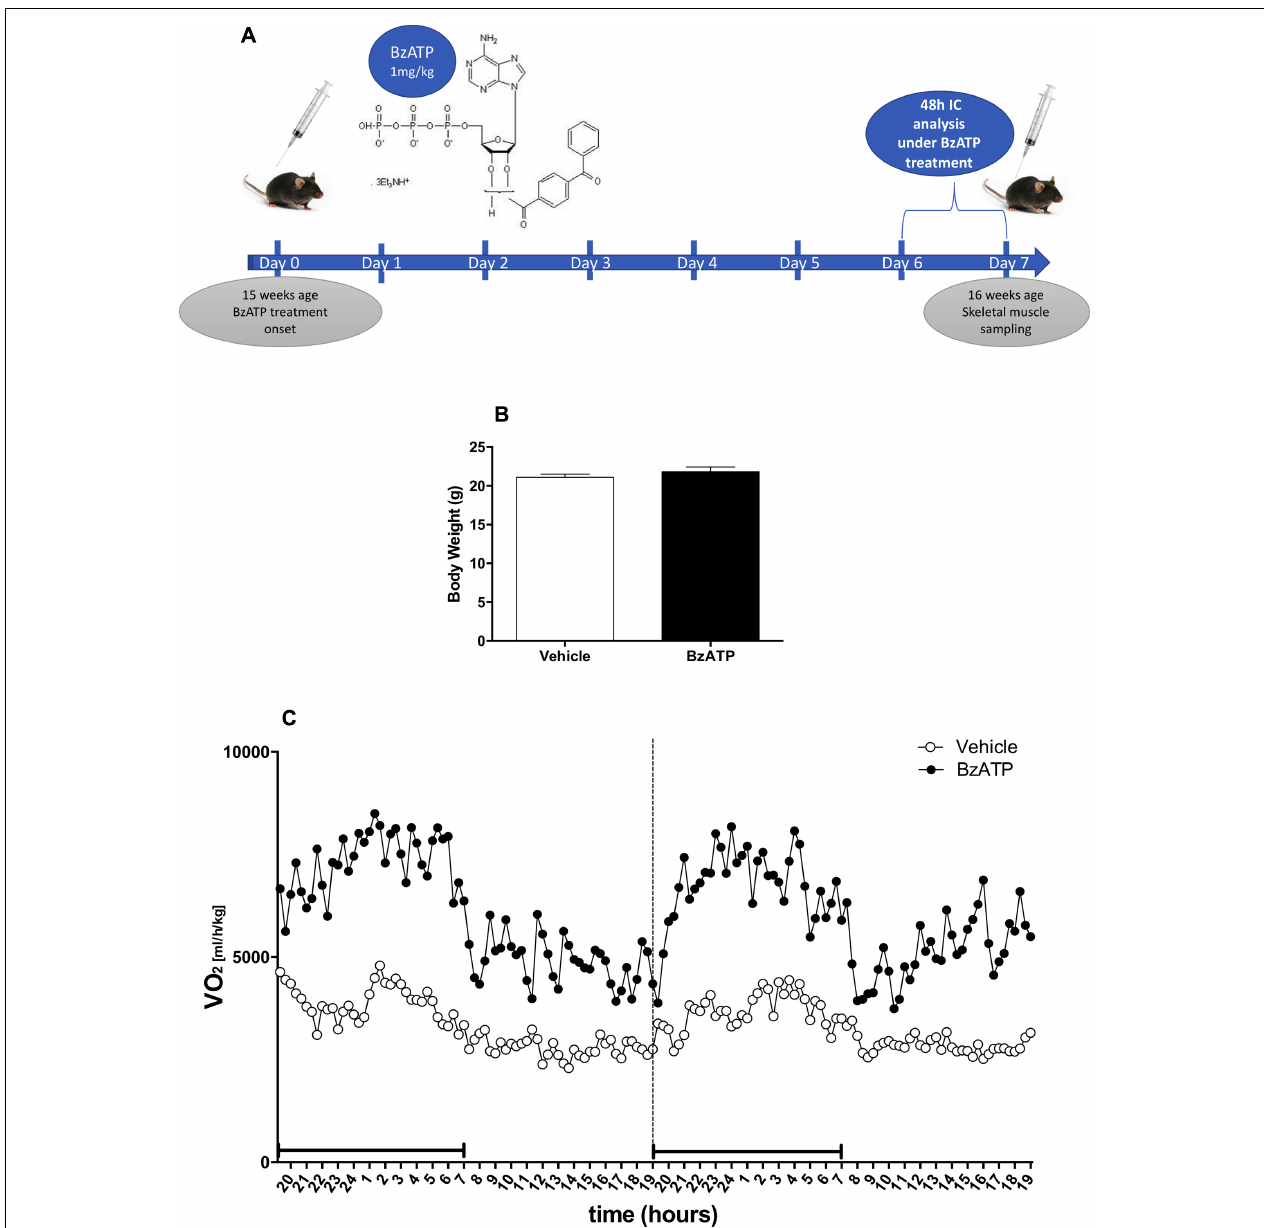
FIGURE 1 | Experimental plan and effects of 7-days BzATP administration on whole oxygen consumption. Adult (15 weeks-old) female C57BL/6J mice were daily i.p., administered with PBS or 1 mg/Kg BzATP for 7 days. At day 5, vehicle ( n = 5) and BzATP-treated mice ( n = 5), were introduced in the metabolic chambers to adapt for 24 h, and then subjected to IC recording for 48 h (days 6 and 7). (A) Schematic representation of experimental plan and execution. (B) Mean ( ± SEM) body weight (g) collected during the IC analysis for 48 h. (C) Mean ( ± SEM) of 48 h metabolic activity expressed as volume of oxygen consumption rate (VO 2 ) (ml/h/Kg), during the entire light/dark cycle. Black line below the recording time ( X -axis) indicates the dark